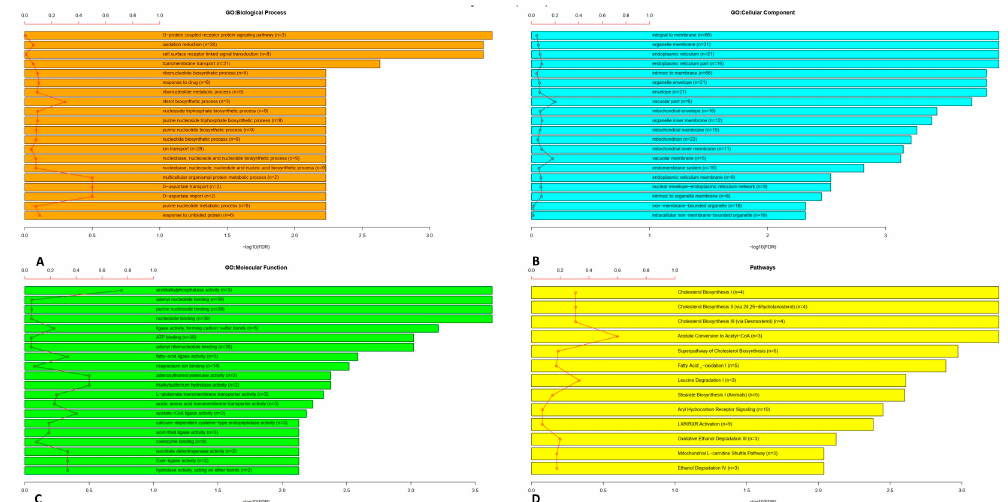
Figure 2. Top 20 Gene Ontology categories: Biological Process (BP) ( A ), Cellular Component (CC) ( B ), Molecular Function (MF) ( C ) and Pathways ( D ) enriched by correlated genes with ACE2 , respectively. The red line represents the percentage between the number of genes related to ACE2 in that category and the total number of genes in the category.